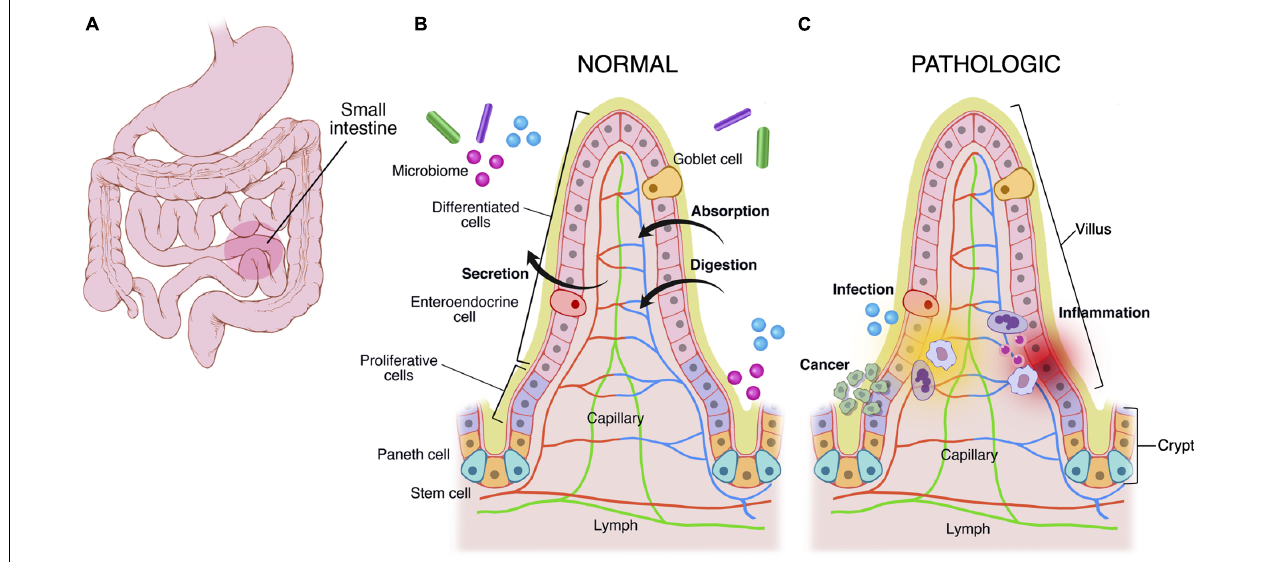
FIGURE 1 | Multiscale physiological features of small intestine of the gastrointestinal tract. The GI tract (A) grossly consists of the esophagus, stomach, small intestine, large intestine, and rectum. The small intestine is made of crypts and villi (B,C) . Crypts are home to the LGR5+ intestinal stem cell, which differentiates into paneth cells, enteroendocrine, goblet cells, and enterocytes. As cells differentiate they migrate up the villus. These cells are covered in a mucus layer and the microbiome, which are all involved in normal homeostatic functions of immune regulation, secretion, absorption, and digestion. (C) Infection, cancer, and inflammatory processes disrupt the gastrointestinal